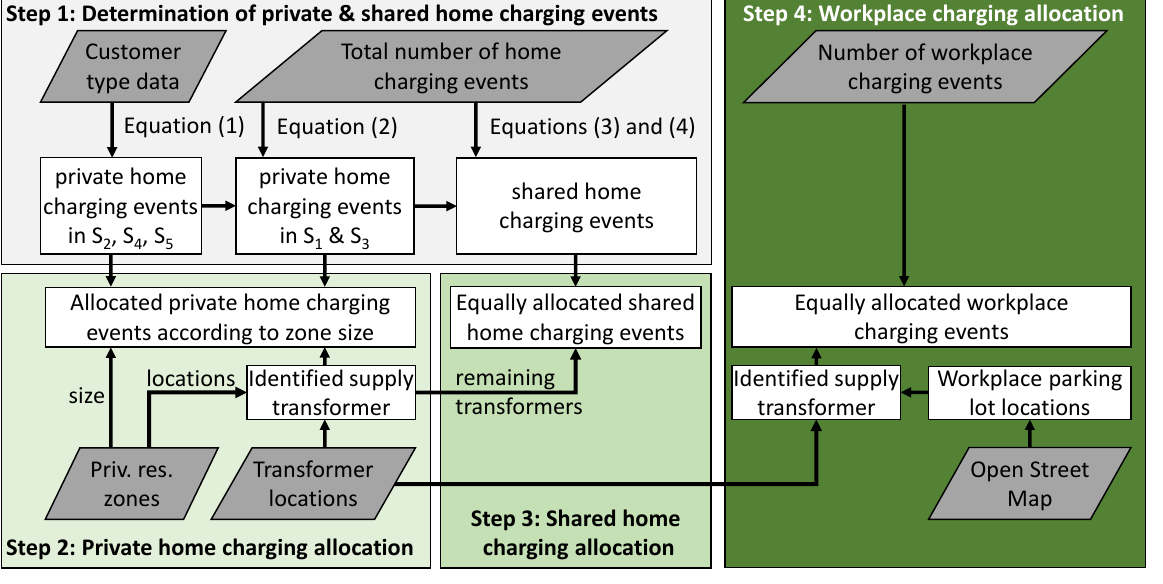
Figure 5. Charging event allocation methodology. Dark-gray-shaded rhomboids indicate the input data, and white-shaded rectangles illustrate the results obtained in each step of the